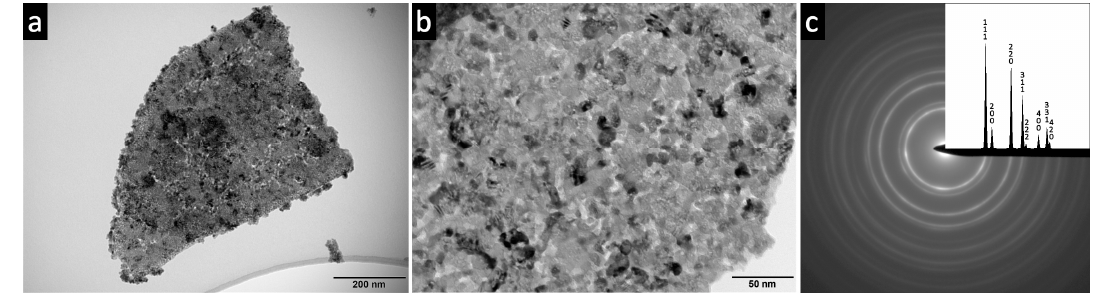
Figure 3. TEM micrographs of the S6 sample nanostructure ( a , b ) and diffraction with analysed face-centred cubic (f.c.c.) CeO 2 phase ( c ).